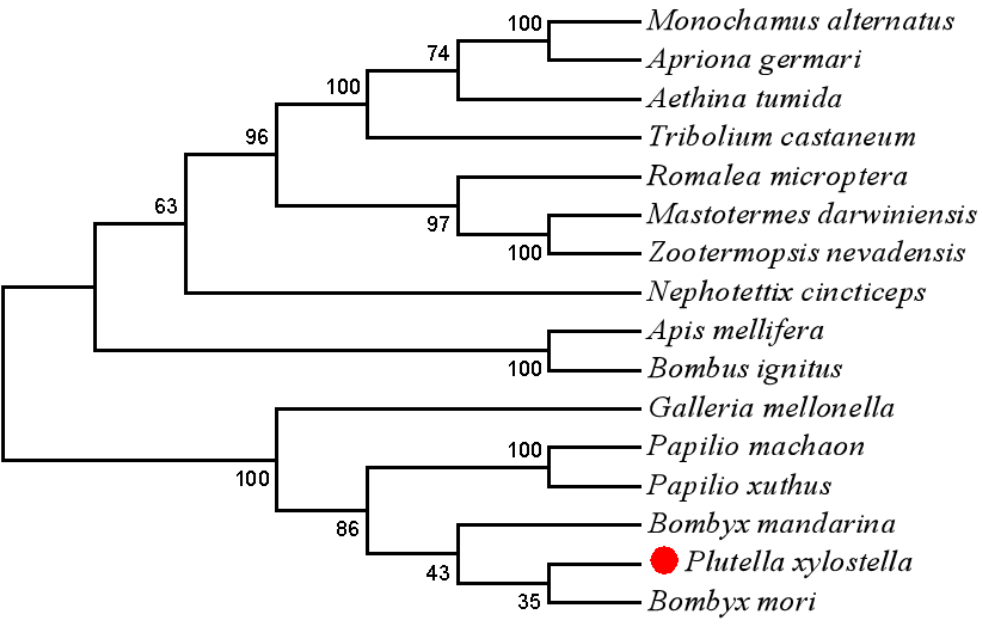
Figure 2. A neighbor-joining phylogenetic tree of Plutella xylostella transferrin (Trf) with other insect Trfs using MEGA 7.0. Bootstrap values from 1000 replications are displayed for each branch.